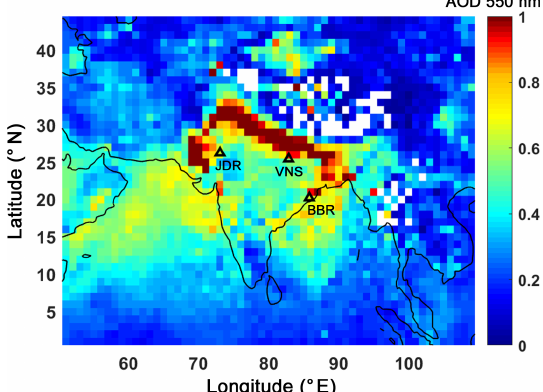
Figure 1. Three distinct base stations: (i) Jodhpur (JDR; 26.25 ◦ N, 73.04 ◦ E) in the western IGP, (ii) Varanasi (VNS; 25.44 ◦ N, 82.85 ◦ E) in the central IGP and (iii) Bhubaneswar (BBR; 20.25 ◦ N, 85.81 ◦ E) in the eastern coastal IGP, from where the aircraft mea- surements were conducted. The spatial map of AOD at 550nm ob- tained from the MODIS sensor (MOD08_D3_6.1, Dark Target and Deep Blue combined mean) on board the Terra satellite during the study period (1–20 June 2016) is shown in the